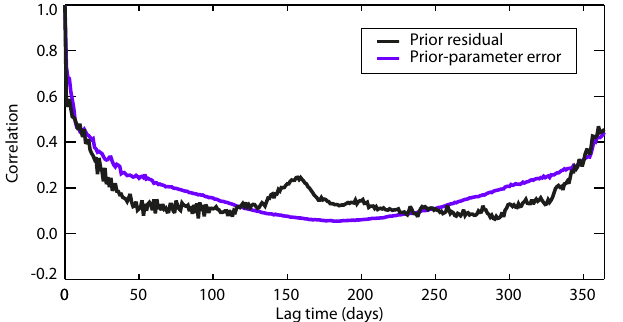
Fig. 1. All-site median of the autocorrelation of the residuals from the prior ORCHIDEE model (black, corresponding to D in Eq. 1) and of the prior-parameter error projected in the flux space (purple, corresponding to HBH T in Eq. 1), as functions of the time lag, for daily NEE.